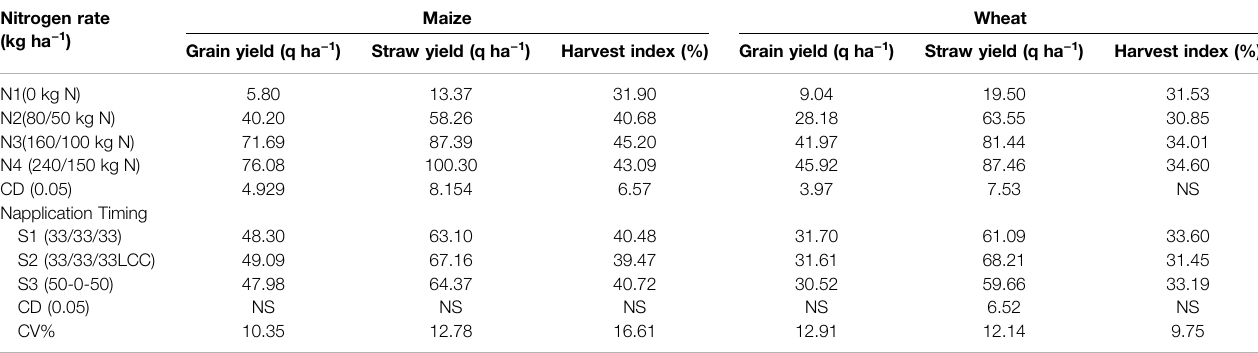
TABLE 7 | Response of various doses and time of nitrogen application on yield (q ha − 1 ) and harvest index. Nitrogen rate Maize Wheat (kg ha − 1 ) Grain yield (q ha − 1